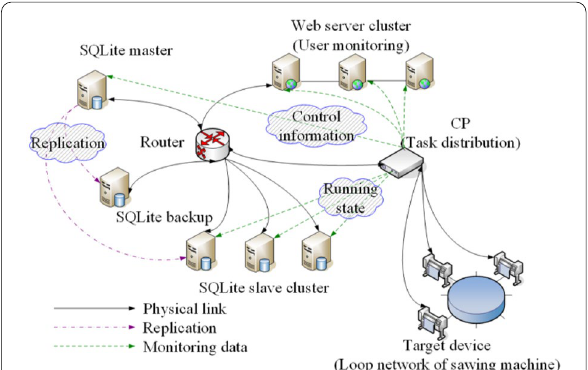
Figure 13 Distributed cloud platform for sawing processing